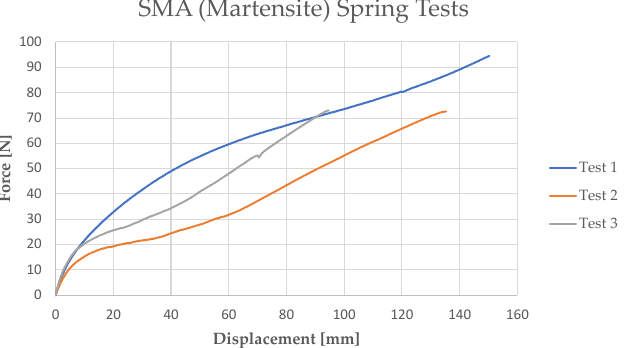
Figure 11. SMA (martensite) spring traction tests.